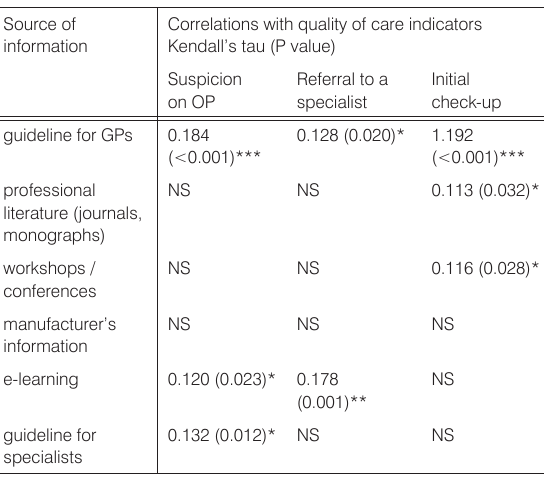
Table 3. Correlations between use of information sources and indi- cators of self-reported quality of care in osteoporosis (OP) management. All calculations are controlled for age.